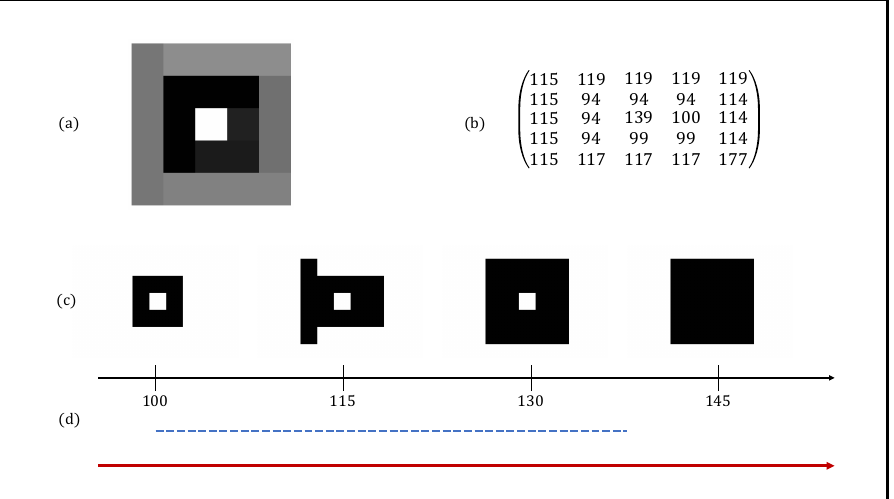
Figure 3. An example of persistent homology for grayscale image. ( a ) A given image, ( b ) a matrix of gray level of given image, ( c ) the filtered cubical complex of the image, ( d ) the persistence barcode according to ( c